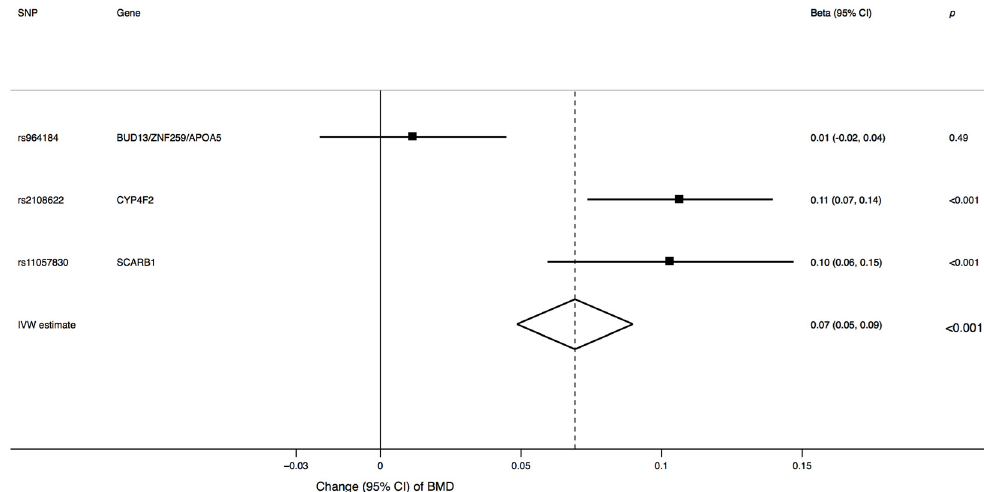
Figure 1. Association between genetically predicted one-standard-deviation increase in circulating α -tocopherol and BMD. CI, confidence interval; BMD, bone mineral density; IVW, inverse, variance weighted; SNP, single-nucleotide polymorphism. Genetically predicted circulating α -tocopherol was not associated with odds of fracture (odds ratio 0.97, 95% confidence interval, 0.91 to 1.05; p = 0.48) (Figure 2). None of the three SNPs was associated with known risk factors for low BMD and fracture at p